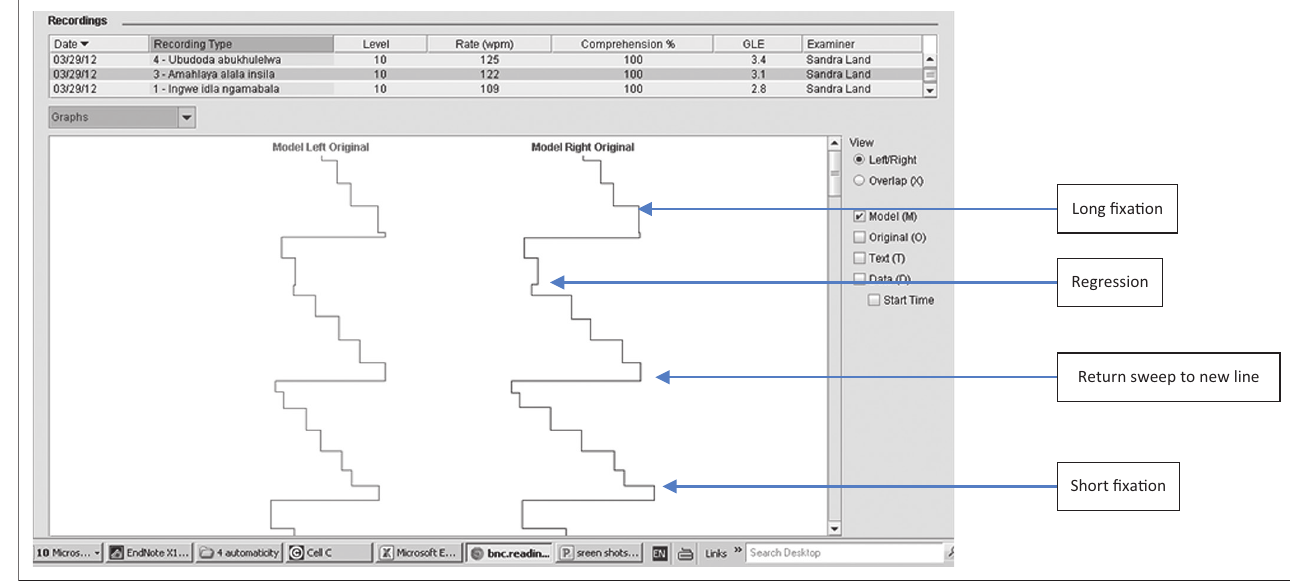
FIGURE 1: Eye movements of a highly skilled reader.